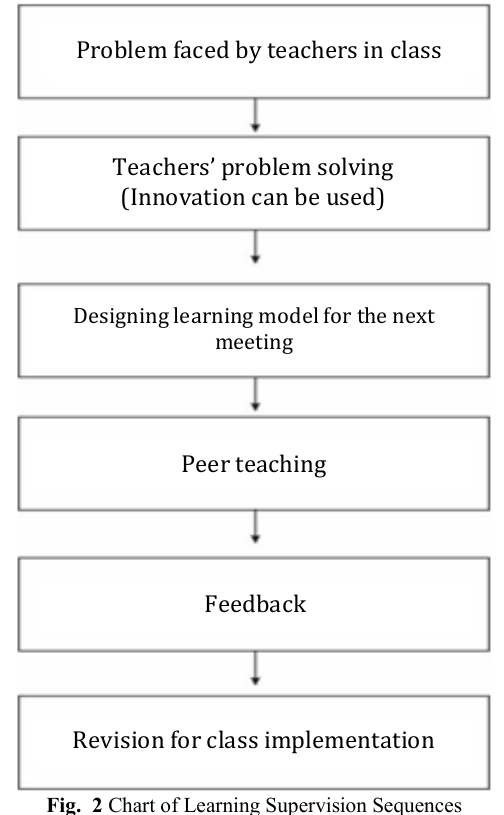
Fig. 2 Chart of Learning Supervision Sequences